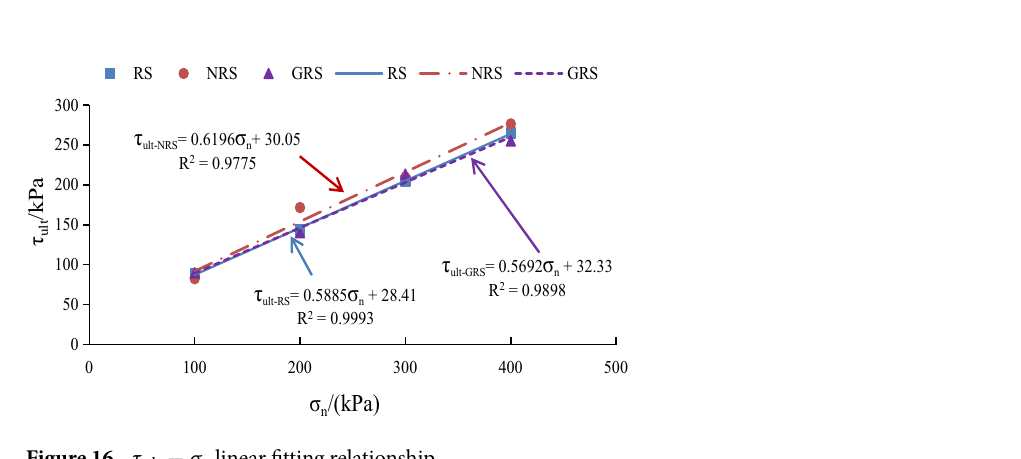
Figure 15. K i − σ n linear fitting relationship.